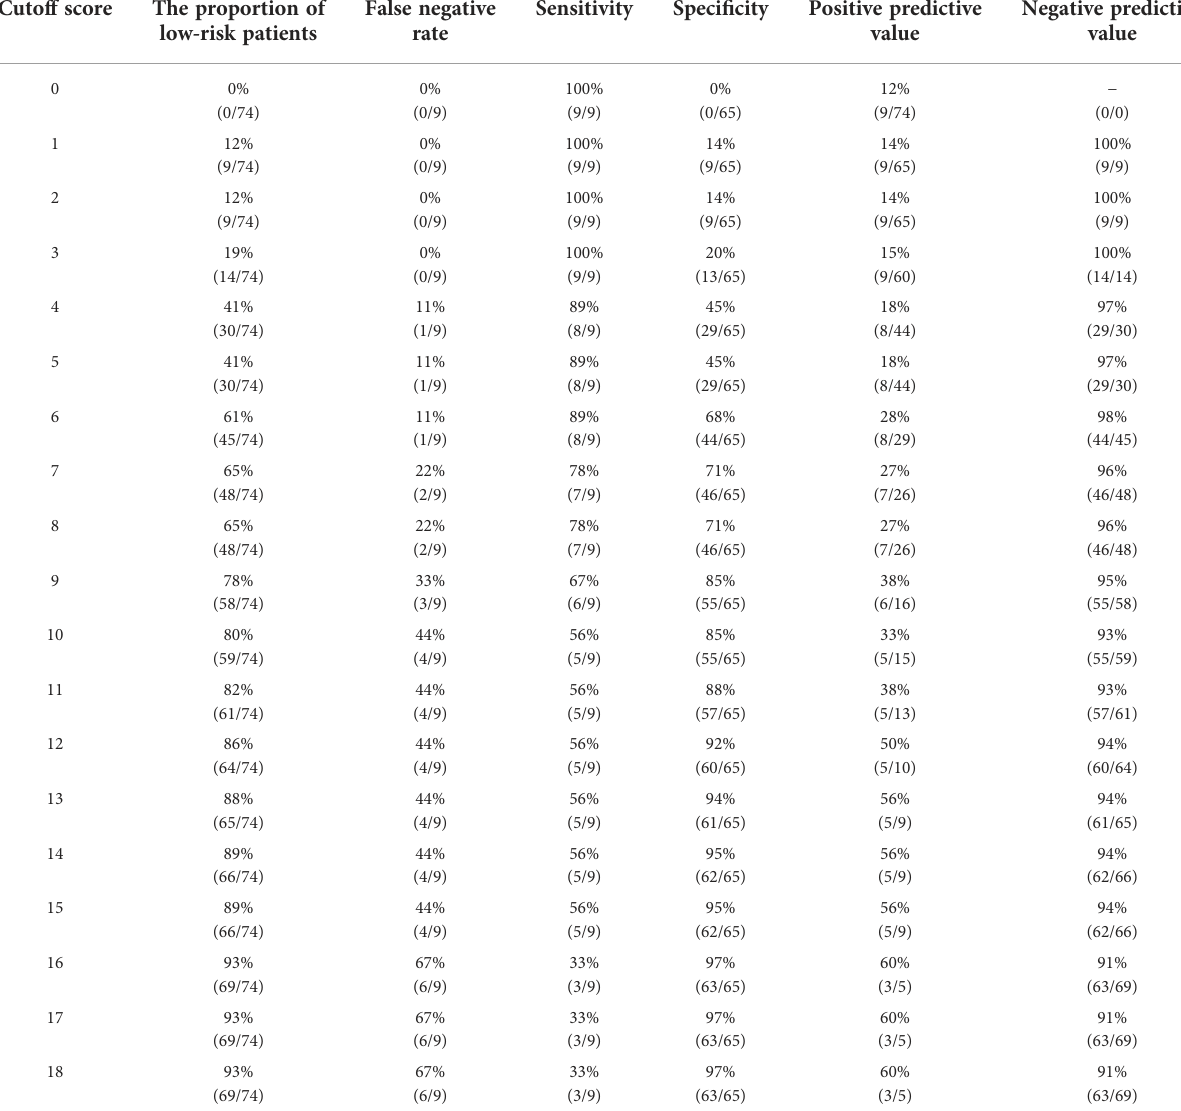
TABLE 3 Determination of the cutoff score for axillary lymph node macrometastasis in the validation cohort. Cutoff